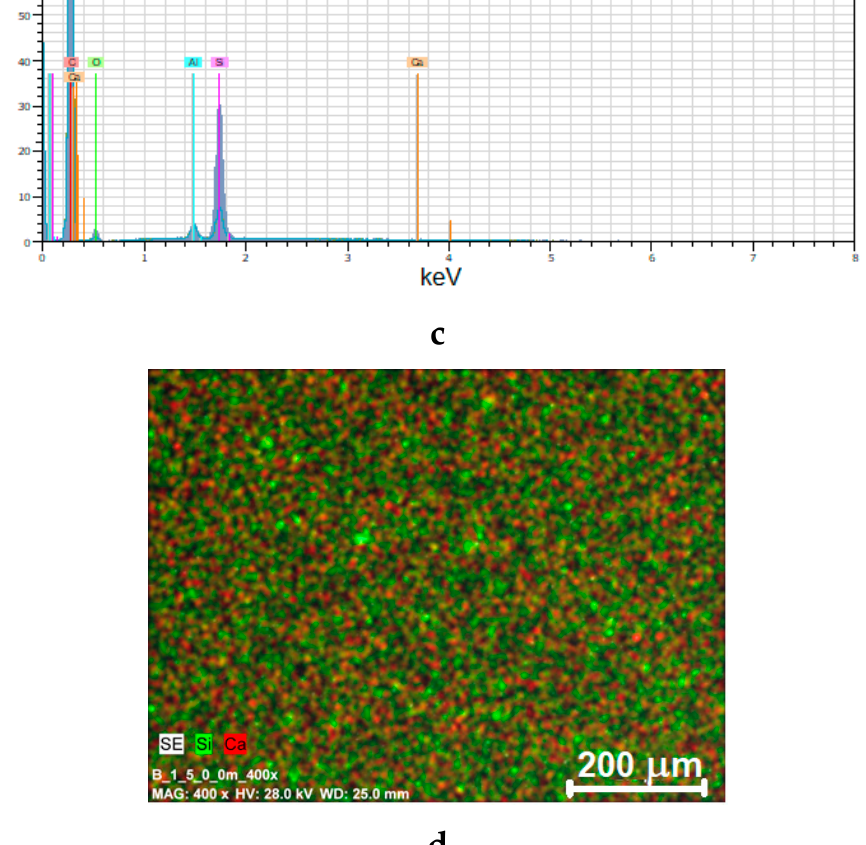
Figure 3. Results of SEM/EDX analysis for non-oriented (NO) sample of HDPE + 5% Sillikolloid P87; SEM image showing EDX analysis points ( a ), elemental composition in the points indicated in Figure 3a ( b ), EDX spectrum ( c ), mapping showing distribution of two selected elements (Si, Ca) ( d ).